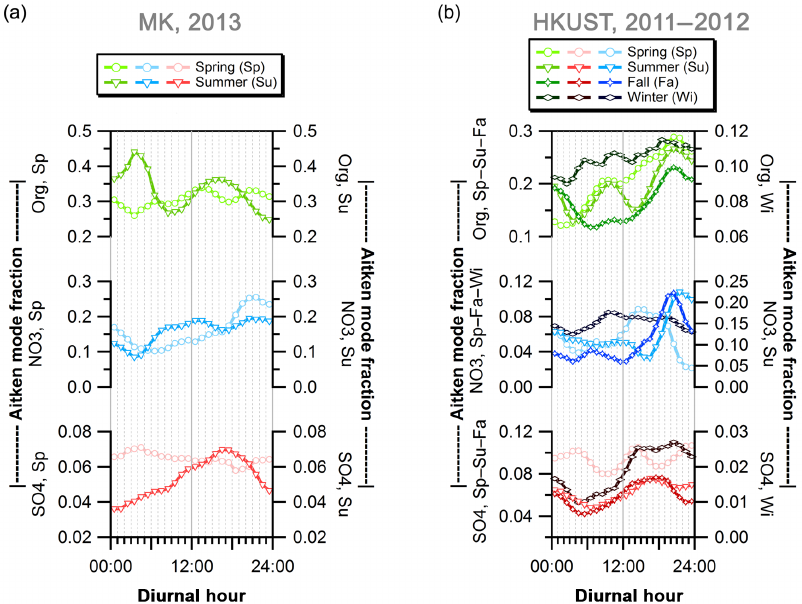
Figure 3. Diurnal variation in the fraction of Aitken-mode particle mass among total submicron species mass for organics (top), nitrate (middle), and sulfate (bottom) at (a) the urban Mong Kong site and (b) the suburban HKUST supersite in different seasons; based on concentrations from bin-median size distributions; seasons denoted by marker color and type of marker